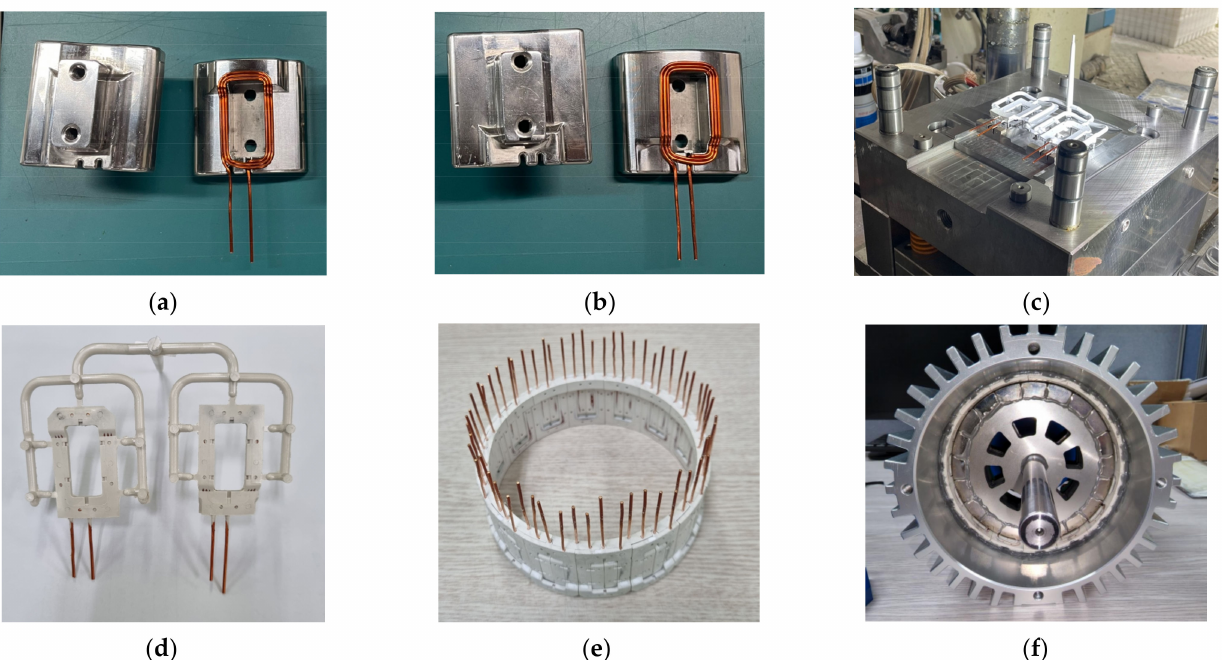
Figure 12. Manufactured motor: ( a ) coil forming of Out coil; ( b ) coil forming of In coil; ( c ) injection molding; ( d ) results of injection molding; ( e ) assembled units of coil; ( f ) assembled motor.